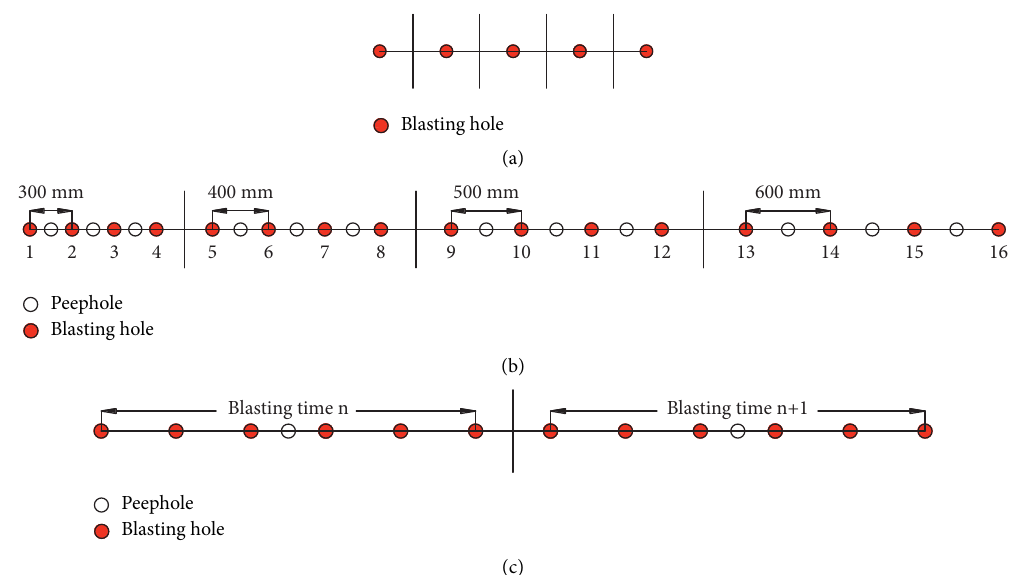
Figure 4: Holes layout in blasting test. (a) Single-hole blasting test. (b) Interval-hole blasting test. (c) Continuous-hole blasting test.